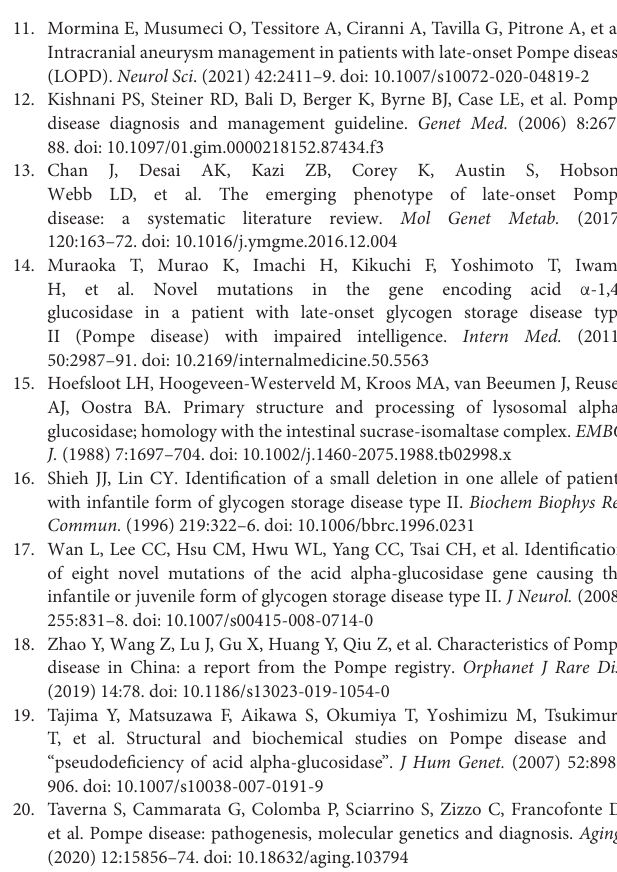
Supplementary Figure 1 | Brain computed tomography (CT) images of the patient. Brain CT scan showed scattered high-density areas in bilateral cerebral sulci (red arrows). Supplementary Figure 2 | Chest CT images of the patient. Chest CT scan showed bilateral pleural effusion and inflammation in the lungs, which was more obvious in the right lung. Supplementary Figure 3 | Clinical presentation of the patient. (A) The patient relied on mechanical ventilation therapy during hospitalization. (B,C) No significant muscle atrophy was seen in the patient and she could depend on home ventilator support on